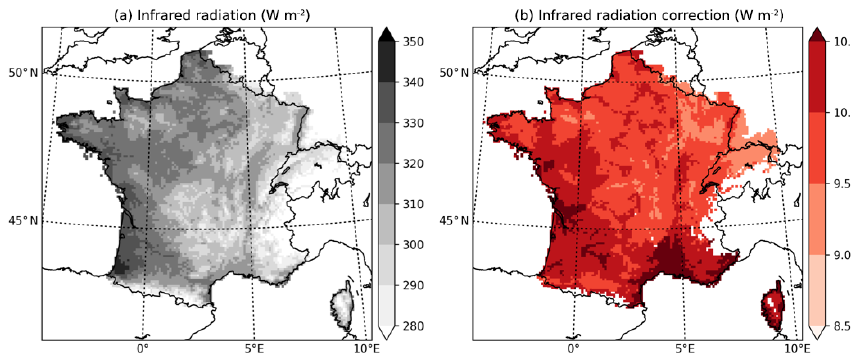
Figure 2. Annual average of uncorrected (a) and corrected (b) downward longwave infrared radiation from SAFRAN analysis.